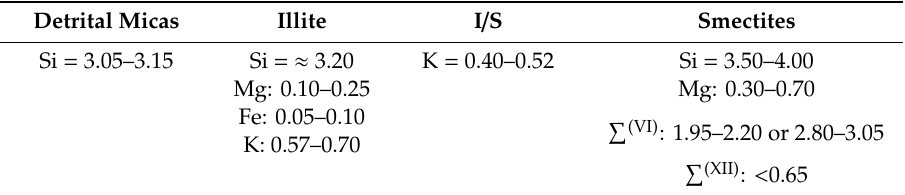
Table 6. Criteria to determinate the chemical formulae by AEM analysis [32,37,38]. Detrital Micas Illite I / S Smectites Si = 3.05–3.15